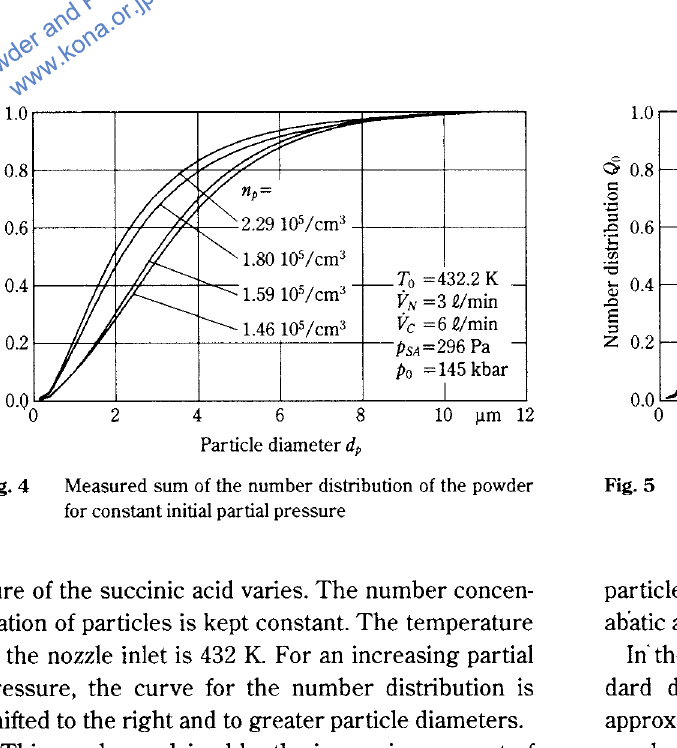
particles generated are shown for both cases, the adi ab"atic and the overheated capillary